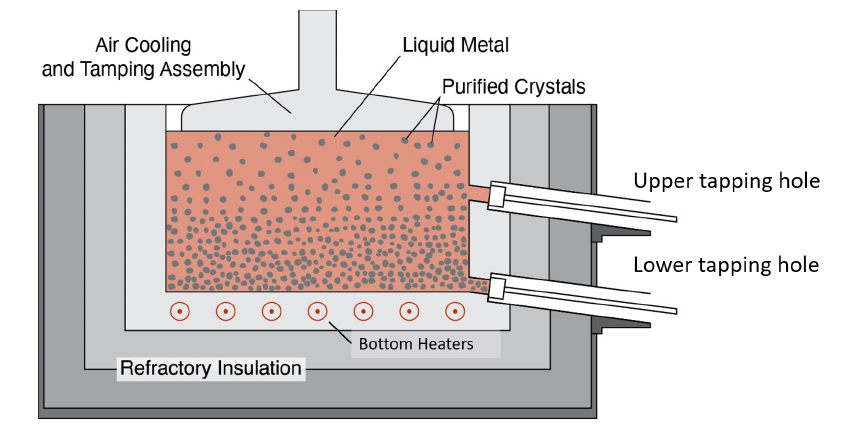
Figure 7. Sketch representation of the Alcoa segregation technique, data from